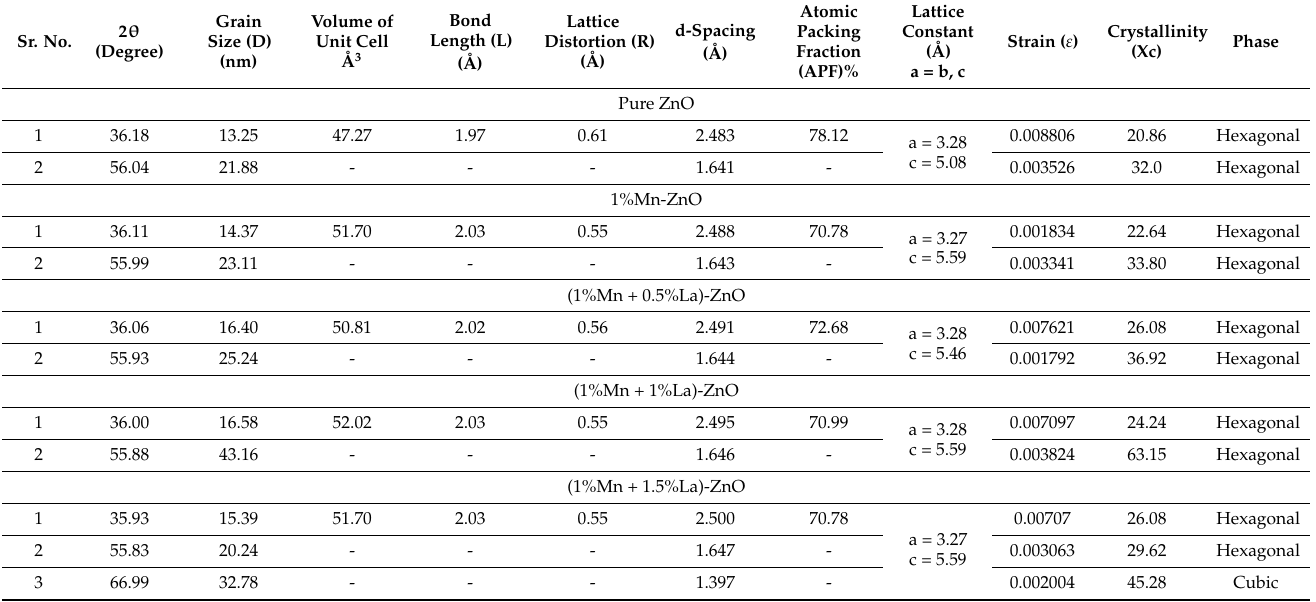
Table 1. Summary of XRD data